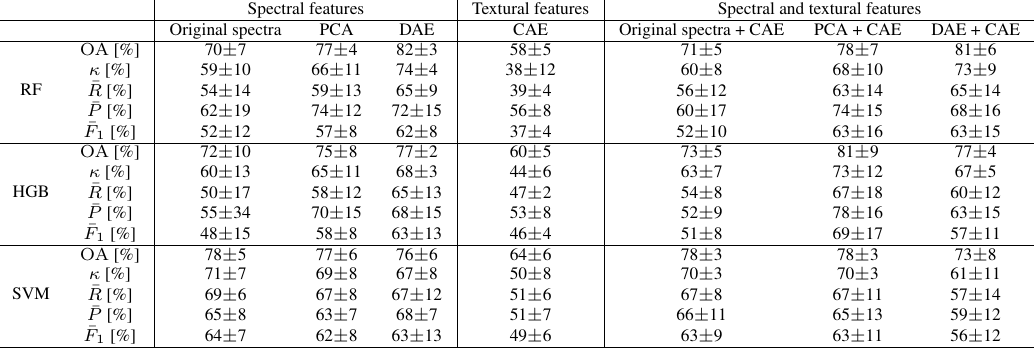
Table 1. The achieved classification results using either RF, HGB or SVM. The evaluation measures display the mean value in addition to ± σ .